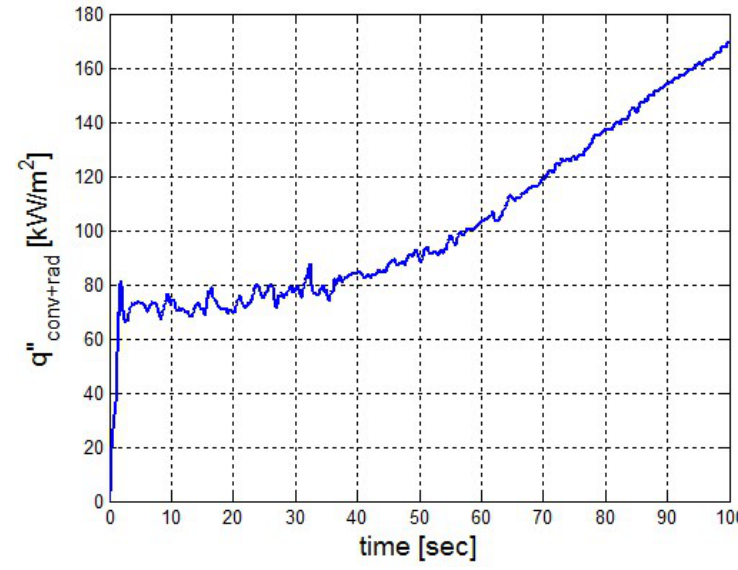
Figure 8. Combined radiative and convective heat flux.